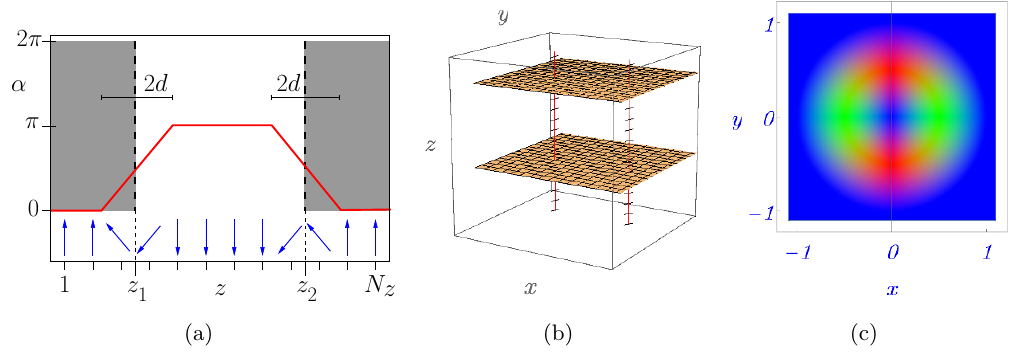
Figure 1 . (a) The pro(cid:12)le function (cid:11) ( z ) of an anti-parallel xy vortex pair with t-links varying in z-direction. The arrows indicate t-links rotating in z direction. The centers of the thick vortices (dashed lines) are located at z 1 and z 2 . In the shaded areas the links have positive, otherwise neg- ative trace. (b) Three-dimensional detail of two pairs of intersecting vortices in 4D. The horizontal planes represent xy-vortices and the vertical lines a t-slice of zt-vortices. The two pairs intersect in four points of a yt-plane. (c) Diagram of a colorful xy-vortex. The color direction ~n of t-links is displayed in the xy-plane for R = 1 and x 0 = y 0 = 0 by maps to RGB-colors, (cid:6) ^ i 7! green, (cid:6) ^ j 7! red and (cid:6) ^ k 7!